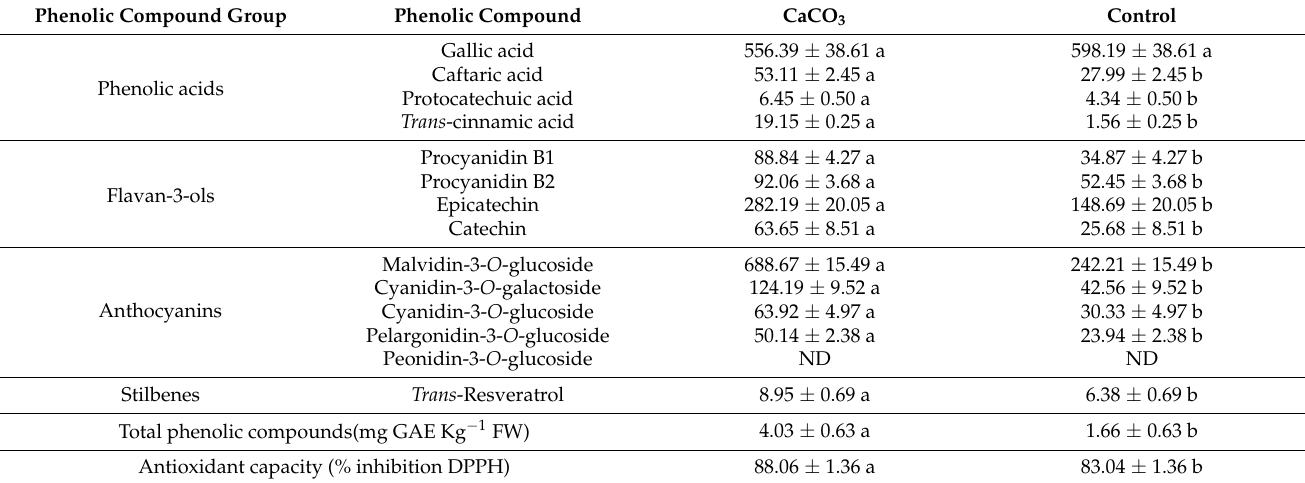
Table 5. Effect of the foliar application of CaCO 3 on the content (mg Kg − 1 FW) of phenolic compounds in ‘Shiraz’